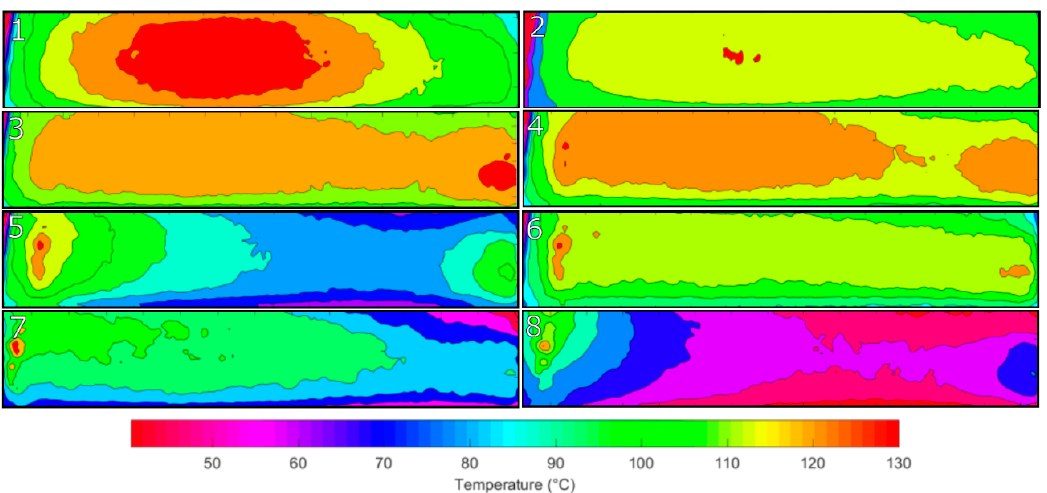
Figure 17. The first repetition of the Greyscale–Threshold hybrid (GT) method is shown in the contour plots of the surface temperature profile measurements shown after each cycle of ablation.